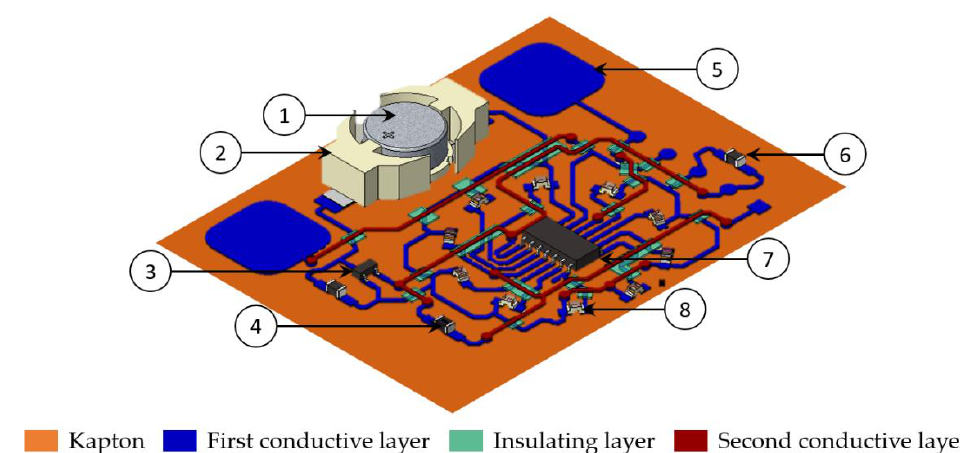
Figure 4. 3D schematic view of the demonstrator composed of: (1) Battery, (2) Battery holder, (3) Voltage regulator, (4) Two 1 µF capacitors, (5) Two printed capacitive pads, (6) 10 kΩ resistor, (7) Microcontroller, and (8) Ten LEDs.